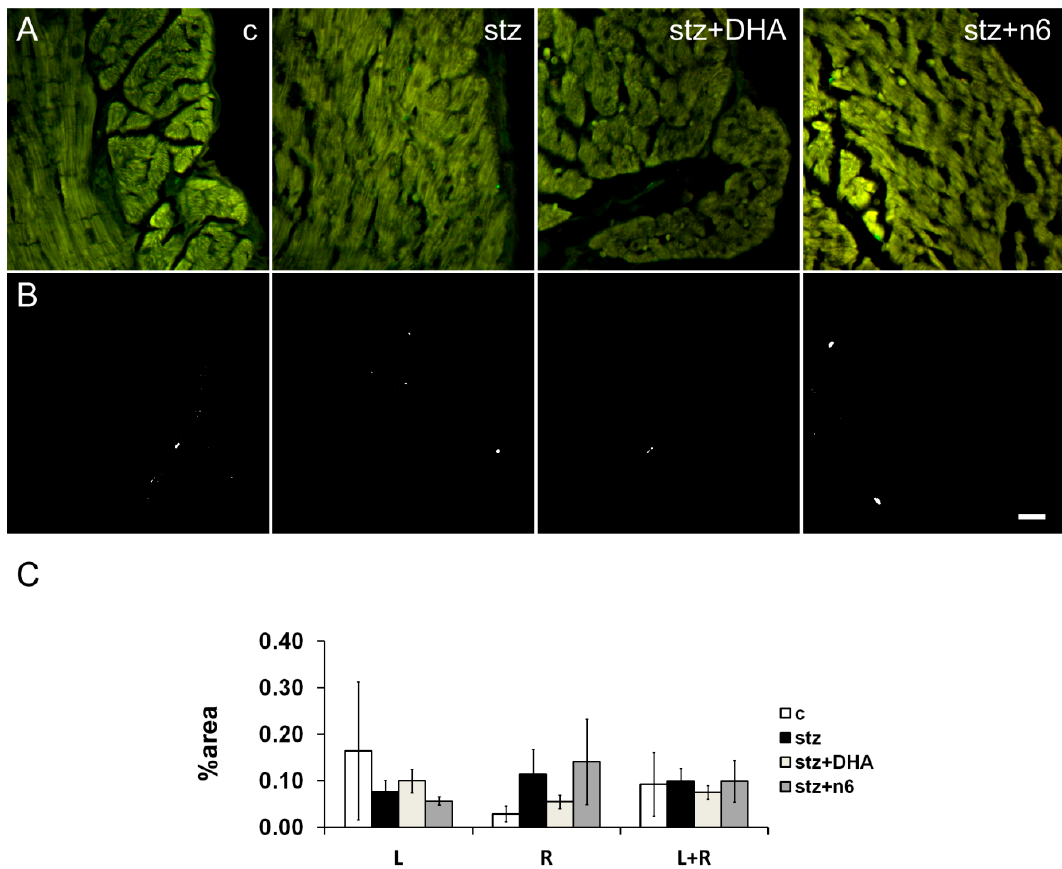
Figure 4. Calcitonin gene related peptide immunoreactive nerve fiber density in subendocardial areas of cardiac septum. ( A ) Representative photomicrographs of right side of the subendocardial area of the cardiac septum stained for neuropeptide CGRP (green). c—Control group; stz—Diabetic group fed standard diet (both diets n6 / n3 ratio ≈ 7); stz + DHA—diabetic group supplemented with n3